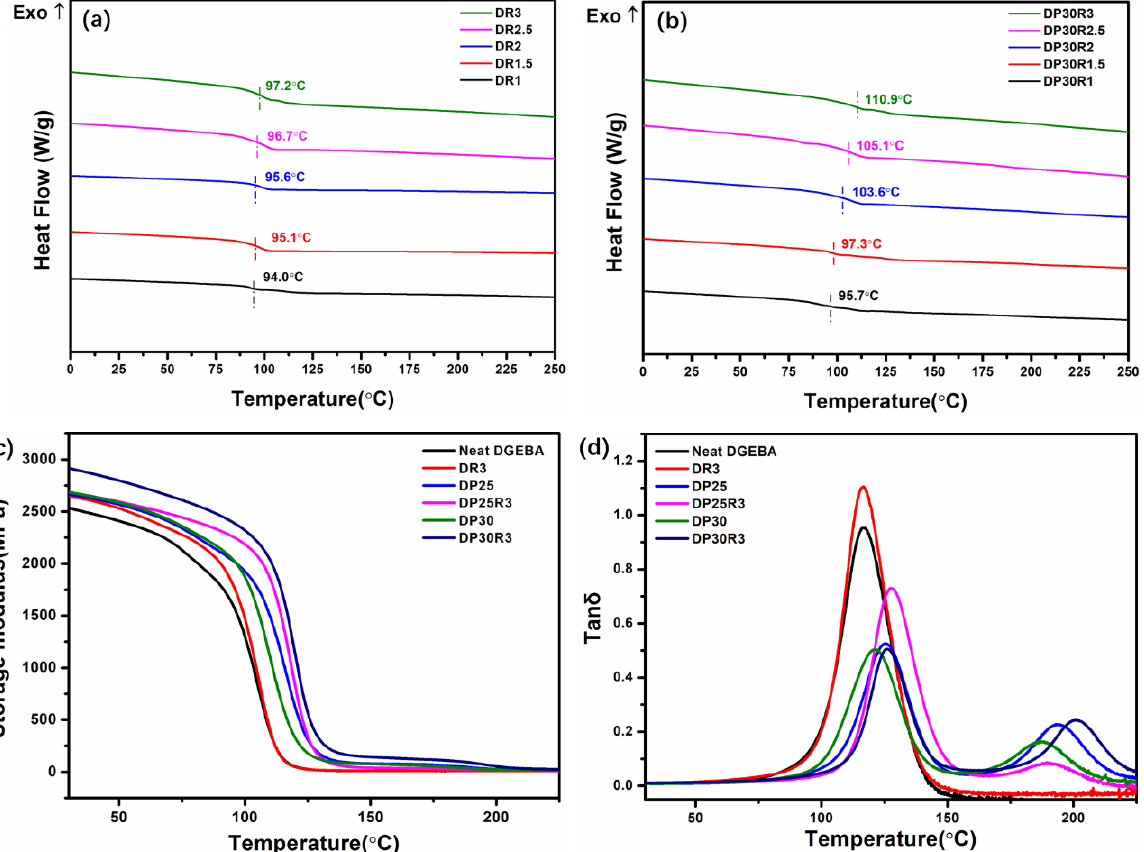
Figure 8. The DSC curves of ( a ) DR n 2 and ( b ) DP30R n 2 . The DMA measurements of ( c ) storage modulus and ( d ) tan δ of the nanocomposites as a function of temperature.